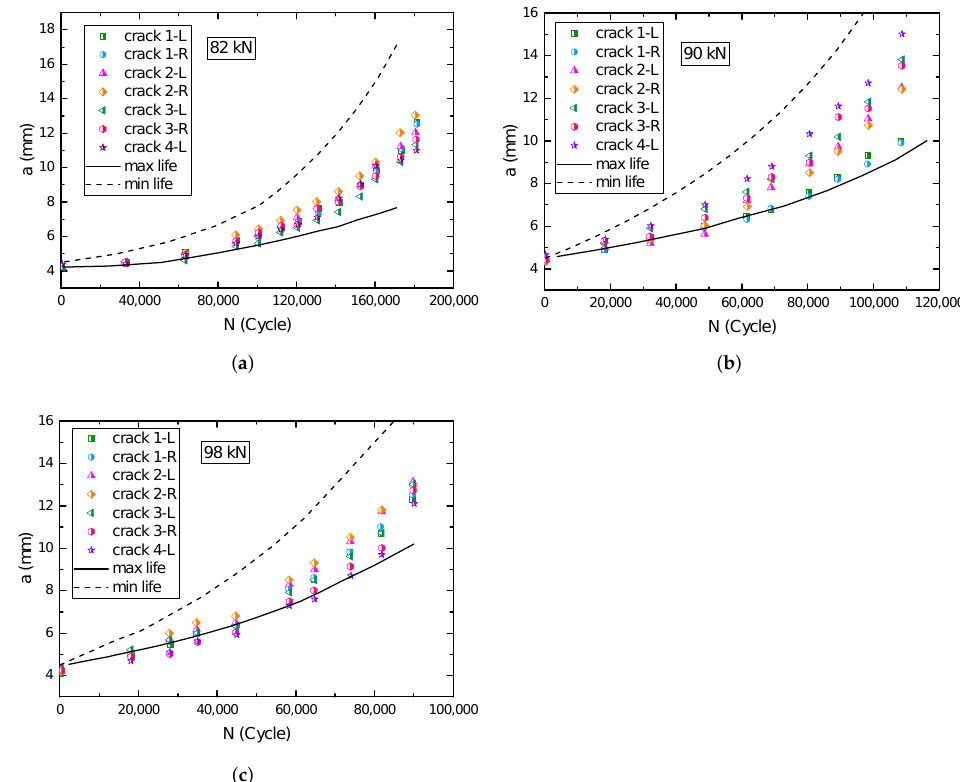
Figure 19. ( a ) Comparison between predicted and experimental values of crack propagation data of P max = 82 kN. ( b ) Comparison between predicted and experimental values of crack propagation data of P max = 90 kN. ( c ) Comparison between predicted and experimental values of crack propagation data of P max = 98